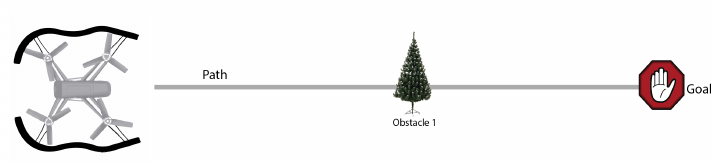
Figure 20. Distribution for one tree-like obstacle.